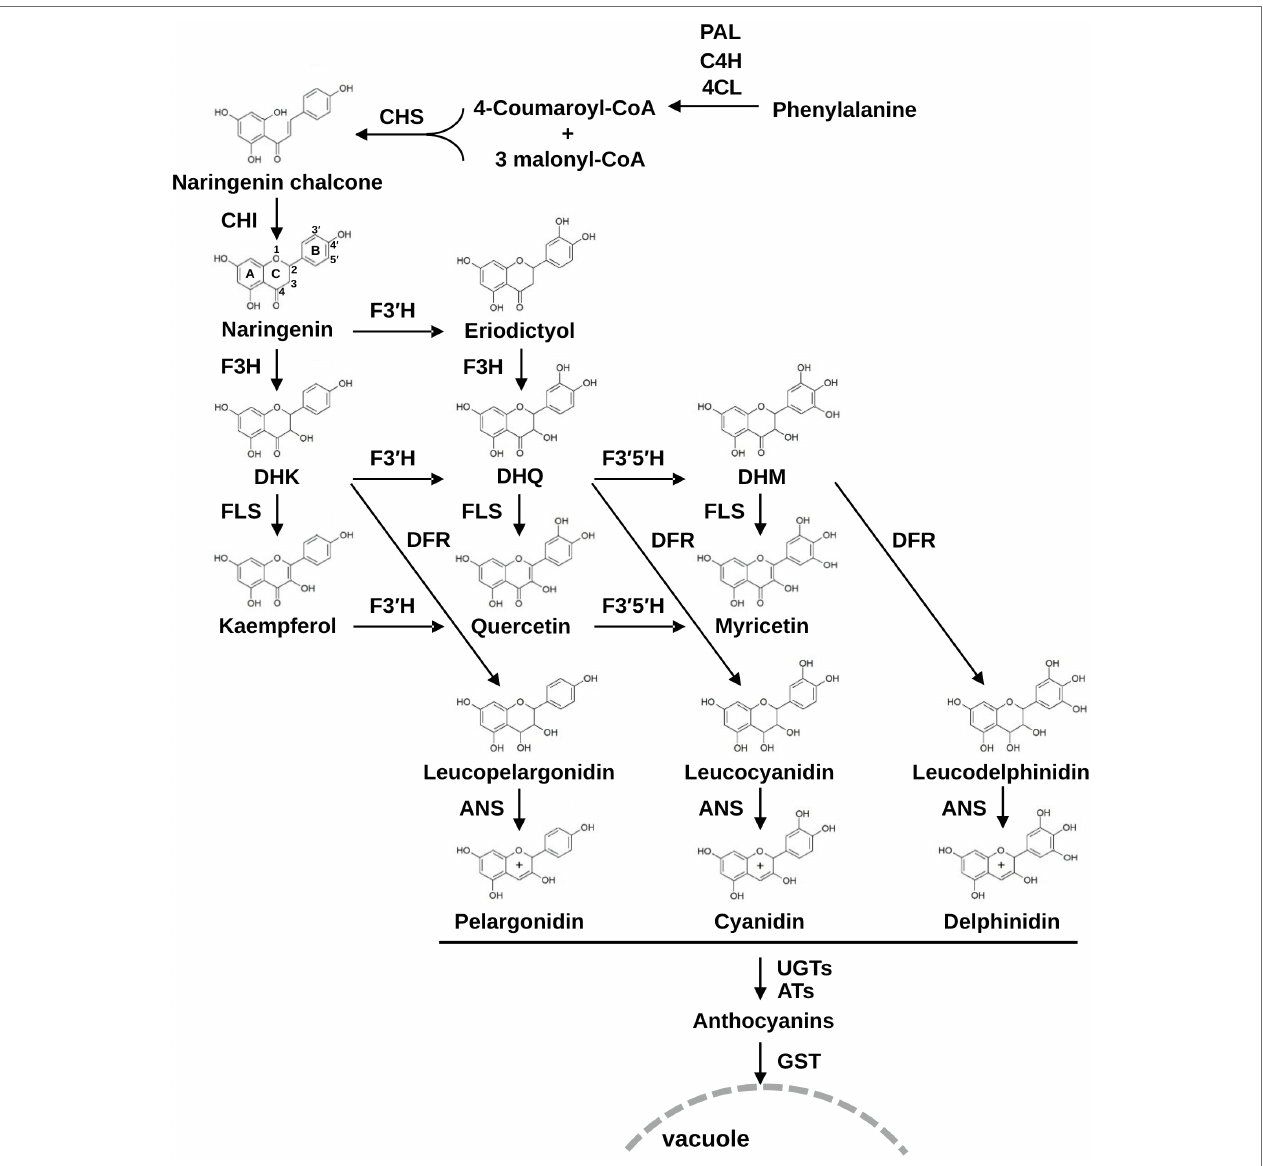
FIGURE 1 | The flavonoid biosynthesis pathway in plants. PAL, phenylalanine ammonia-lyase; C4H, cinnamate 4-hydroxylase; 4CL, 4-coumaroyl:CoA-ligase; CHS, chalcone synthase; CHI, chalcone isomerase; F3H, flavanone 3 β -hydroxylase; F3 ′ H, flavonoid 3 ′ -hydroxylase; F3 ′ 5 ′ H, flavonoid 3 ′ ,5 ′ -hydroxylase; DFR, dihydroflavonol 4-reductase; FLS, flavonol synthase; ANS, anthocyanidin synthase; UGTs, UDP-glucosyltransferase; ATs, acyltransferases; GSTs, glutathione S - transferases; DHK, dihydrokaempferol; DHQ, dihydroquercetin; DHM,